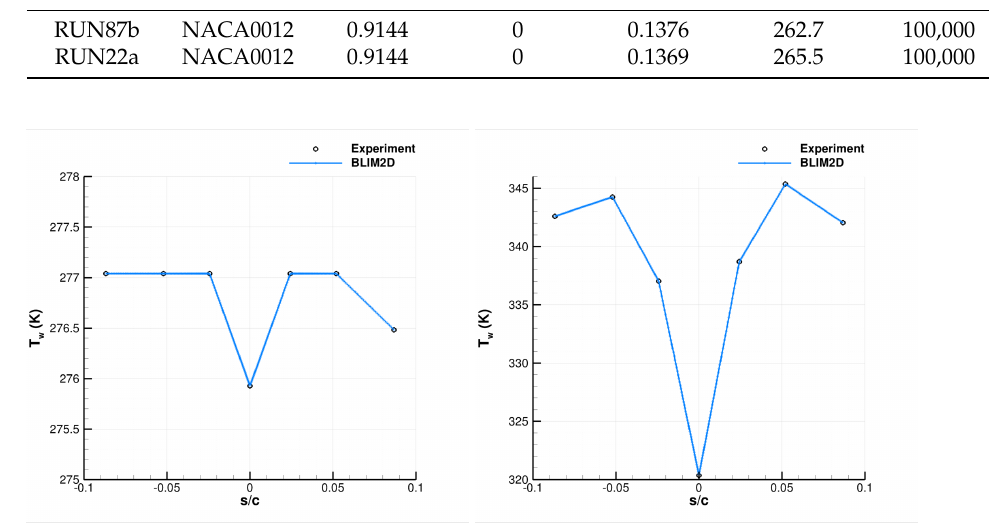
Figure 7. Wall temperature in the test cases of Table 1. ( Left ): RUN87b. ( Right ):